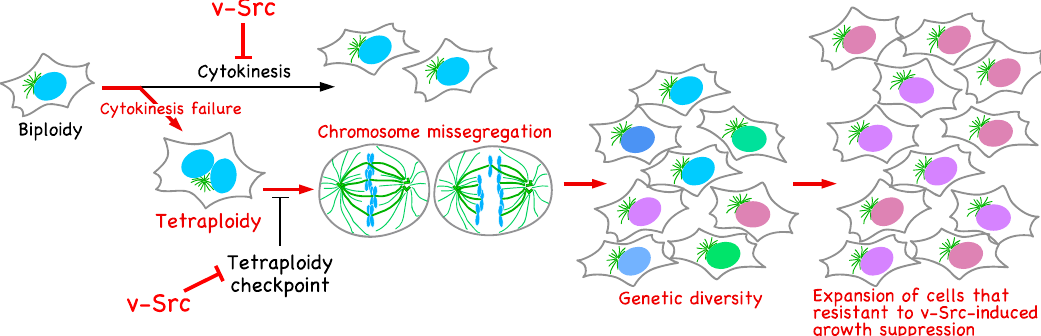
Figure 3. Genetic diversification in v-Src-expressing cells. v-Src induces tetraploidization through cytokinesis failure. The activation of the tetraploidy checkpoint in tetraploid cells is suppressed by v-Src. Tetraploid cells give rise to chromosome mis-segregation, leading to genetic diversification. v-Src causes growth suppression; however, among cells with broad genetic diversity, cells resistant to v-Src-induced growth suppression can evolve and continue to proliferate.